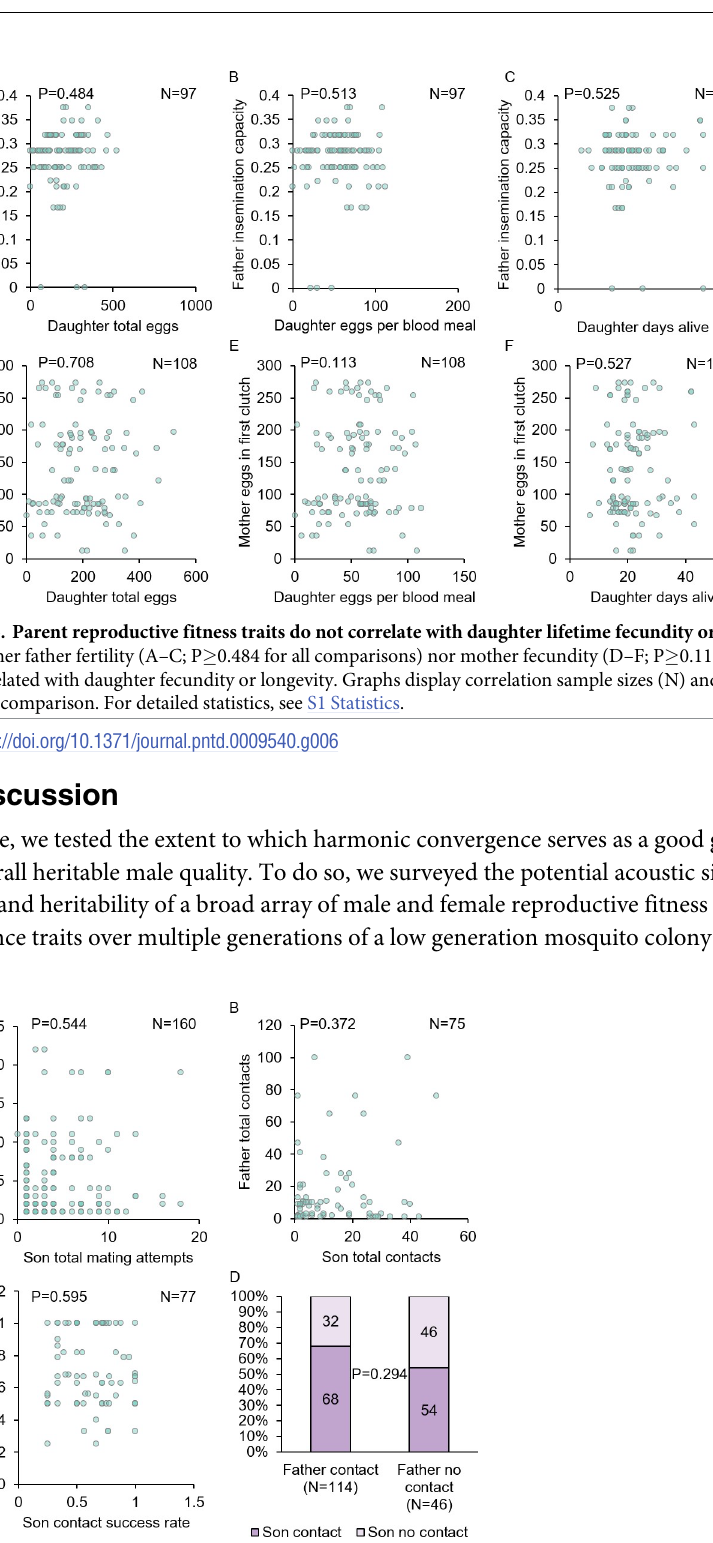
Fig 7. Father flight performance displays low heritability. Father flight performance metrics did not correlate with the same metrics in their sons (A–D; P � 0.294 for all comparisons). Graphs display correlation sample sizes (N) and LMM or GZLMM P-values for each comparison. For detailed statistics, see S1